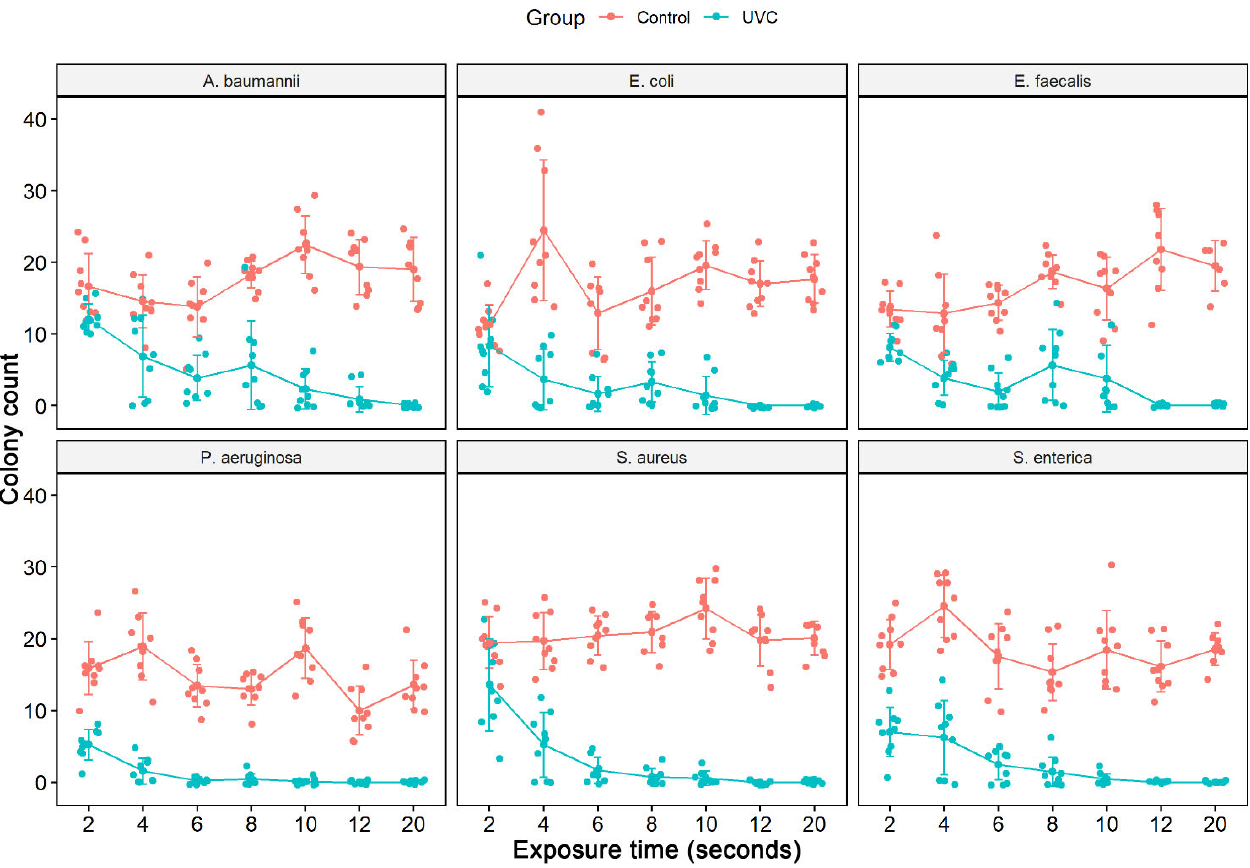
Figure 3. Counting the number of colonies forming units (CFU/mL) of the assay from the liquid medium in different ATCCs bacterial strains ( S. aureus (ATCC 6538), P. aeruginosa (ATCC 15442), S. enterica (ATCC 10708), E. coli (ATCC 25922), A. baumannii (ATCC 19606) and E. faecalis (ATCC 29212)). The number of CFU/mL was quantified in the control group (no treatment) and in the bacterial suspensions (1:100 dilution) after exposure to the UV ‐ C system for 2, 4, 6, 8, 10, 12, and 20 s. 3.2. Exposure to the UV-C System in Solid Medium The culture exposure at different times (2 to 20 s) to the UV-C system was able to inhibit the in vitro growth of all bacterial strains tested, ATCCs, and MDR/ESKAPE-E group (10 4 CFU/mL) (Figure 4) with a statistically significant reduction in colony count compared to the control group (not treated with UV-C system) (Table 3). The exposure of ATCCs bacterial strains to the UV-C system for only 2 s was able to reduce 100% in the CFU/mL count in all ATCCs strains (10 4 CFU/mL), namely, S. aureus , P. aeruginosa , E. coli , A. baumannii , E. faecalis , except the S. enterica strain which had a statistically significant reduction of 99.7%. At the exposure time of 4 s, this strain had its CFU/mL count reduced to 100%. At UV-C exposure times of 6, 8, and 10 s, the total reduction (100%) result remained constant (Figure 4, Table